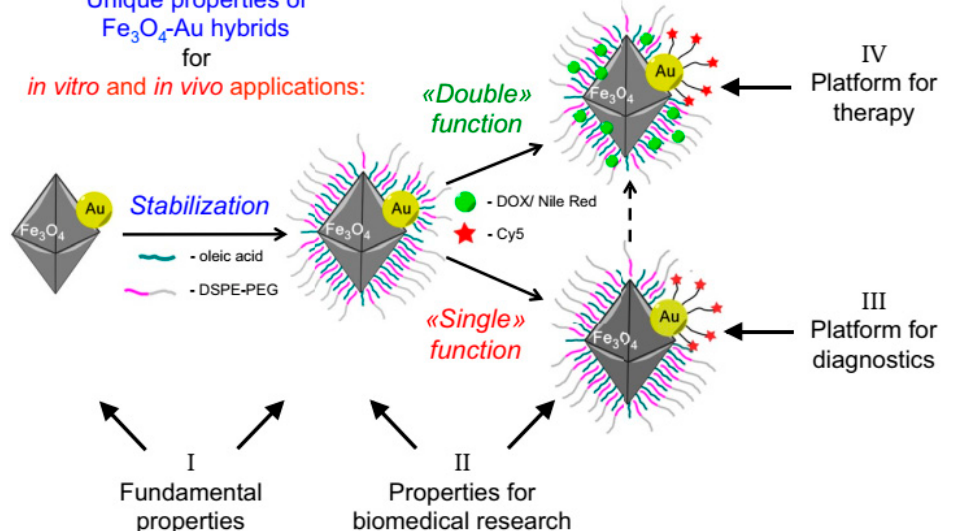
Figure 4. Schematic illustration of Au-Fe 3 O 4 multifunctional Janus nanoparticles as a cancer diagnos- tic and therapeutic agent [74].